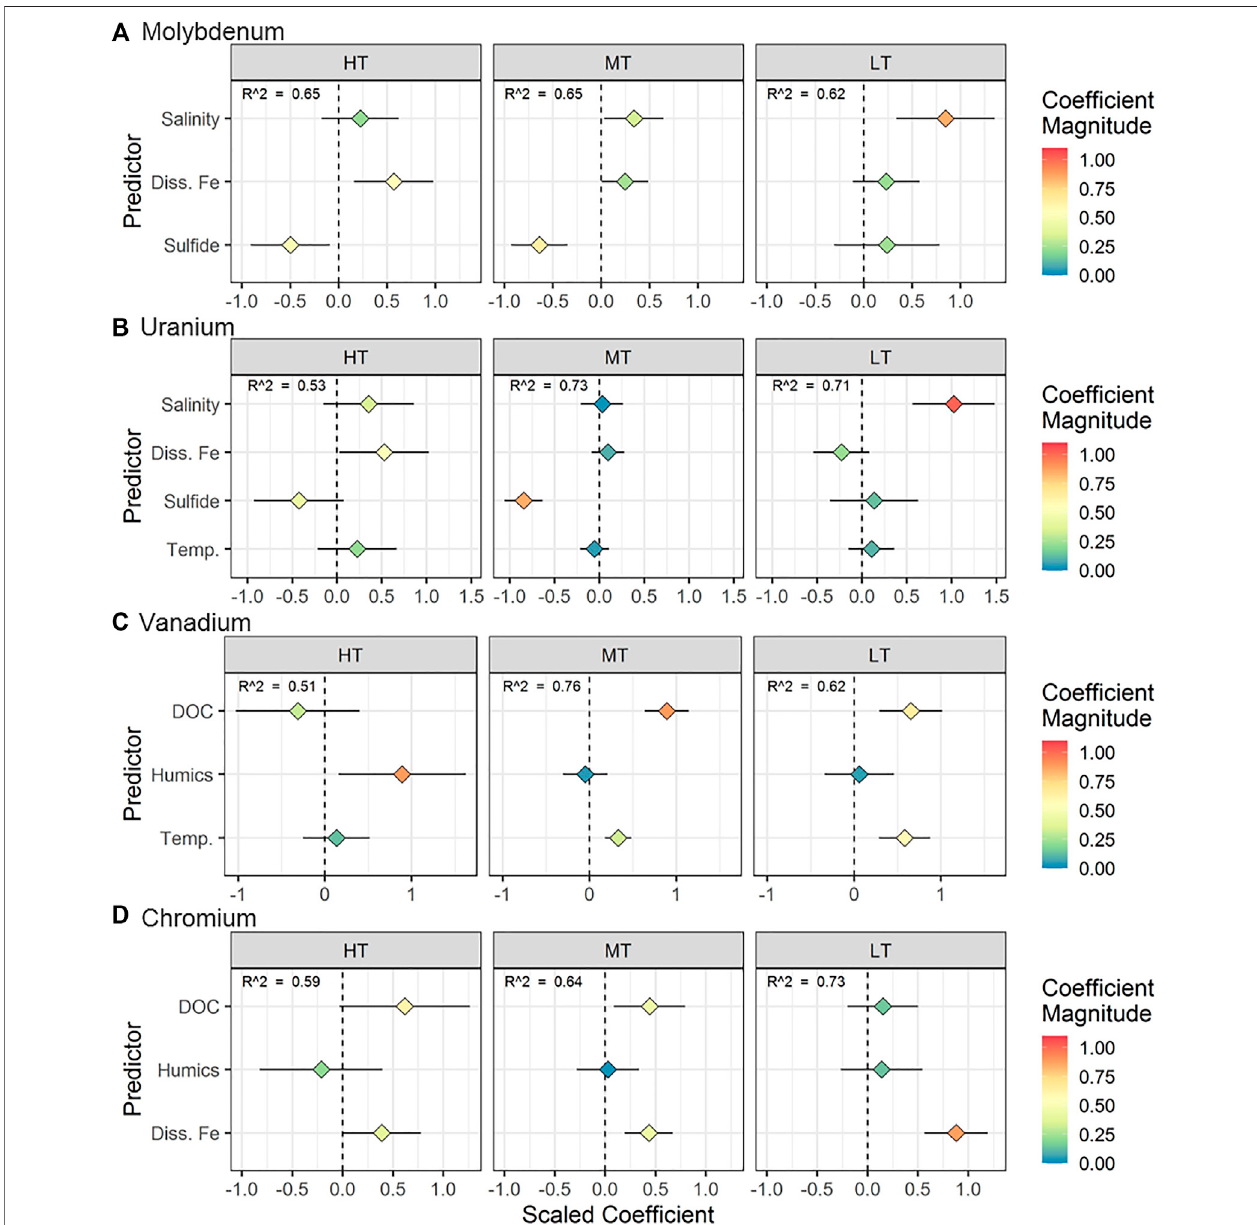
FIGURE 7 | Regression results for (A) Mo, (B) U, (C) V, and (D) Cr for measurements taken along the STE transect (space effects). The horizontal axis represents the scaled coef fi cient for each predictor in the multiple linear regression (vertical axis). The color of the points shows the absolute magnitude of the coef fi cient. More extreme values (positive or negative) represent a stronger relationship between the predictor and the metal concentration. The horizontal lineassociated with each point represents the 95% con fi dence interval for the coef fi cient. For points where the con fi dence interval does not intersect 0, the p value for the coef fi cient is < 0.05.